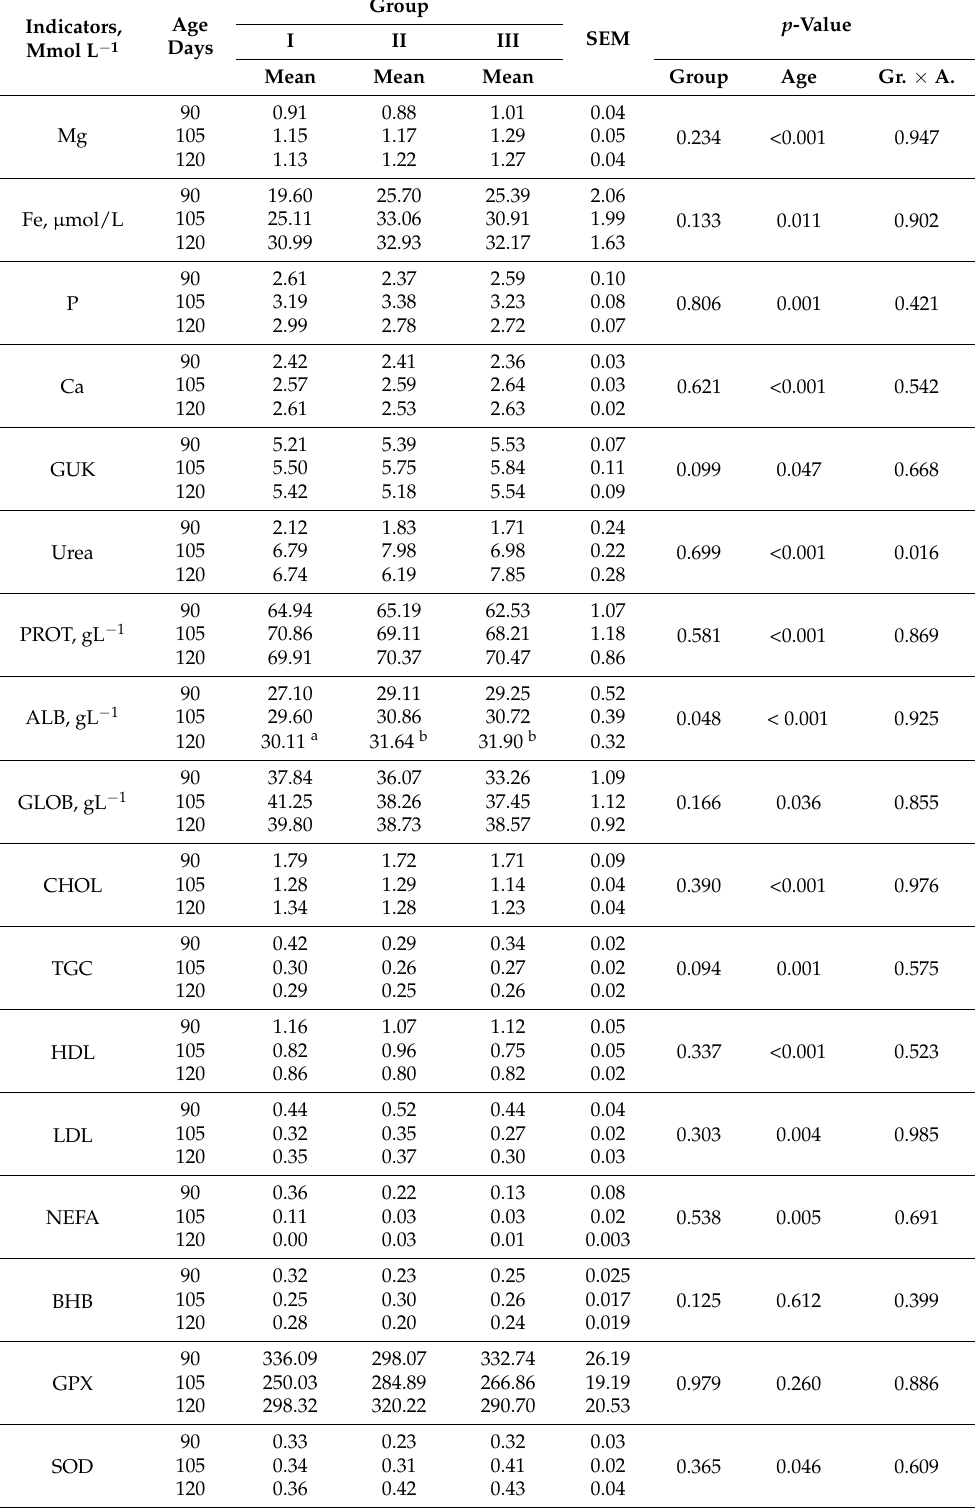
Table 7. Blood biochemical indicators in